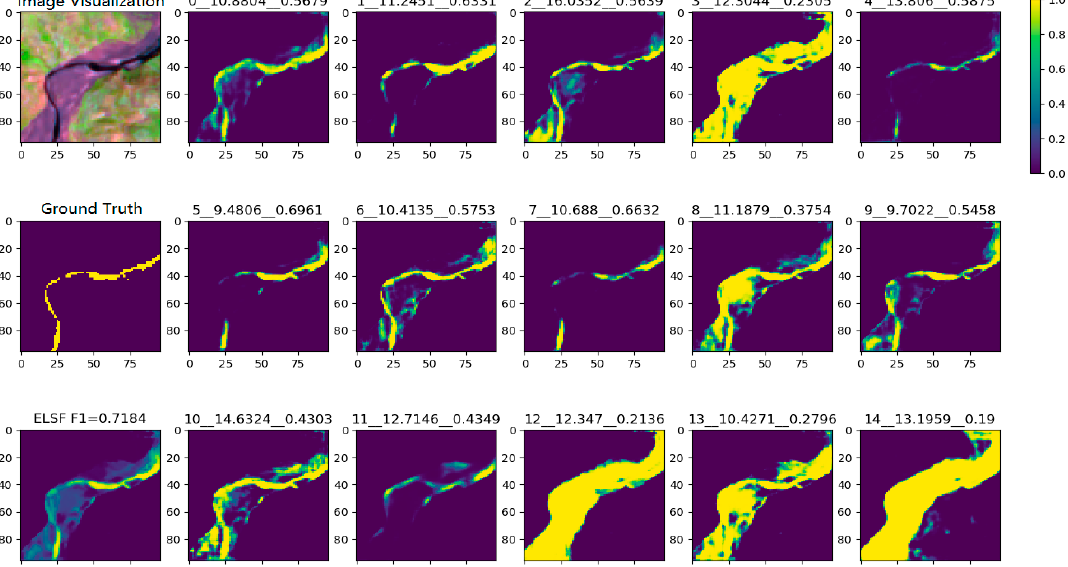
Figure 14. Figures of sample visualization, SVM, UNet segmentation fraction results (row 1), sample ground truth, MultiResUNet, NFL, ELSF segmentation fraction results (row 2). Figure 15 shows the binary results of the same test sample from Figure 13 and Figure 14. Since the CNN model output is a value that ranges from 0 to 1, we consider values higher than 0.5 to be water pixels, and those equal to or lower than 0.5 to be land pixels. Then, we are able to calculate the F1-score using the segmentation results of different methods according to the ground-truth label of the test sample.